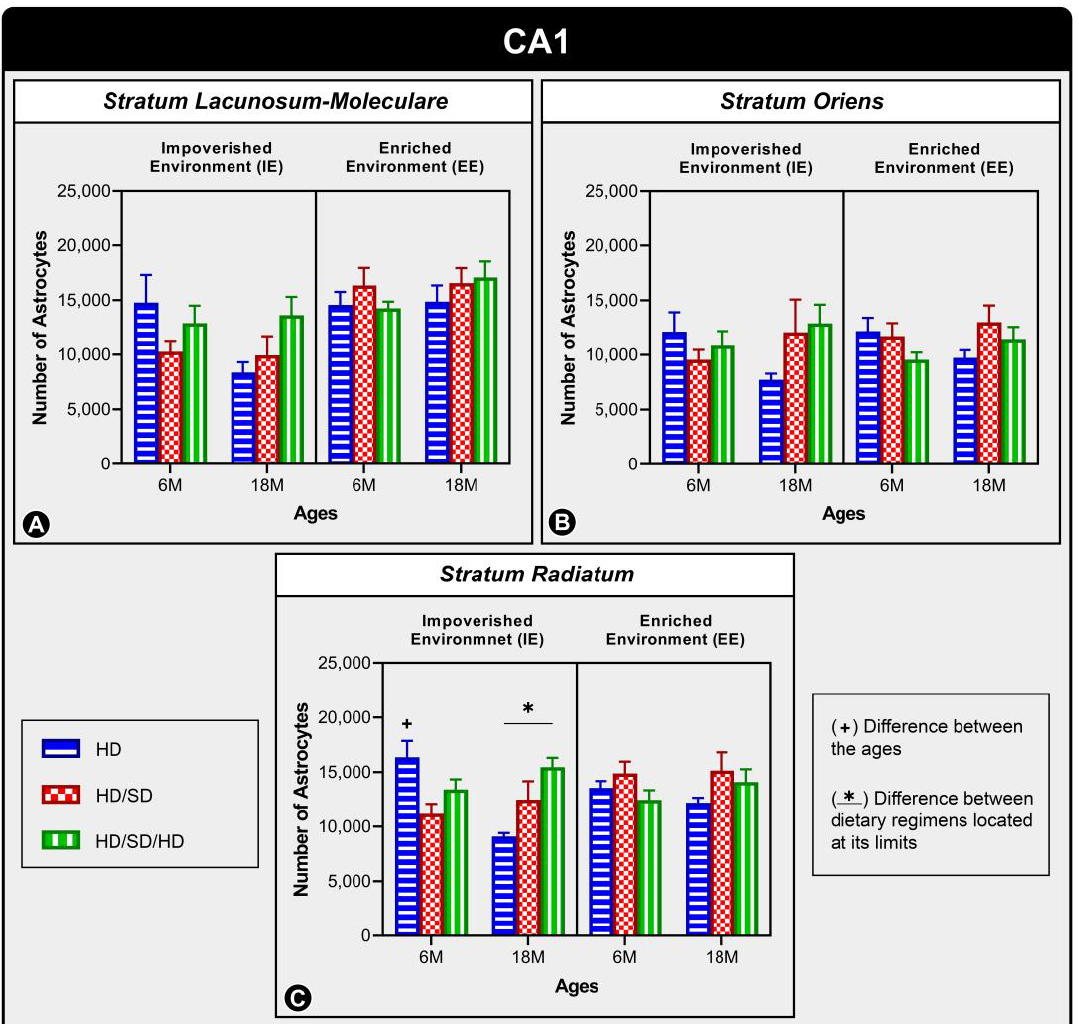
Figure 3. Graphical representation of astrocyte numerical estimation in CA1’s three layers: Stratum Lacunosum-Moleculare ( A ), Stratum Oriens ( B ), and Stratum Radiatum ( C ) under the effects of environment, age, and diet. The graph shows the quantitative results of astrocytes from these layers in the 6-month-old age group (6M) and 18-month-old age group (18M) reared in standard, impoverished environment (IE), and enriched environments (EE) and submitted to one of three types of diet: HD, hard diet (in blue) = pelleted chow, HD/SD, hard diet/soft diet (in red) = pelleted and mashed chow, and HD/SD/HD, hard diet/soft diet/hard diet (in green). In this graph, no statistically significant differences were found between the investigated variables. The symbol (+) indicates a statistically significant age-related difference, while the symbol (*) indicates a difference between diet regimes.